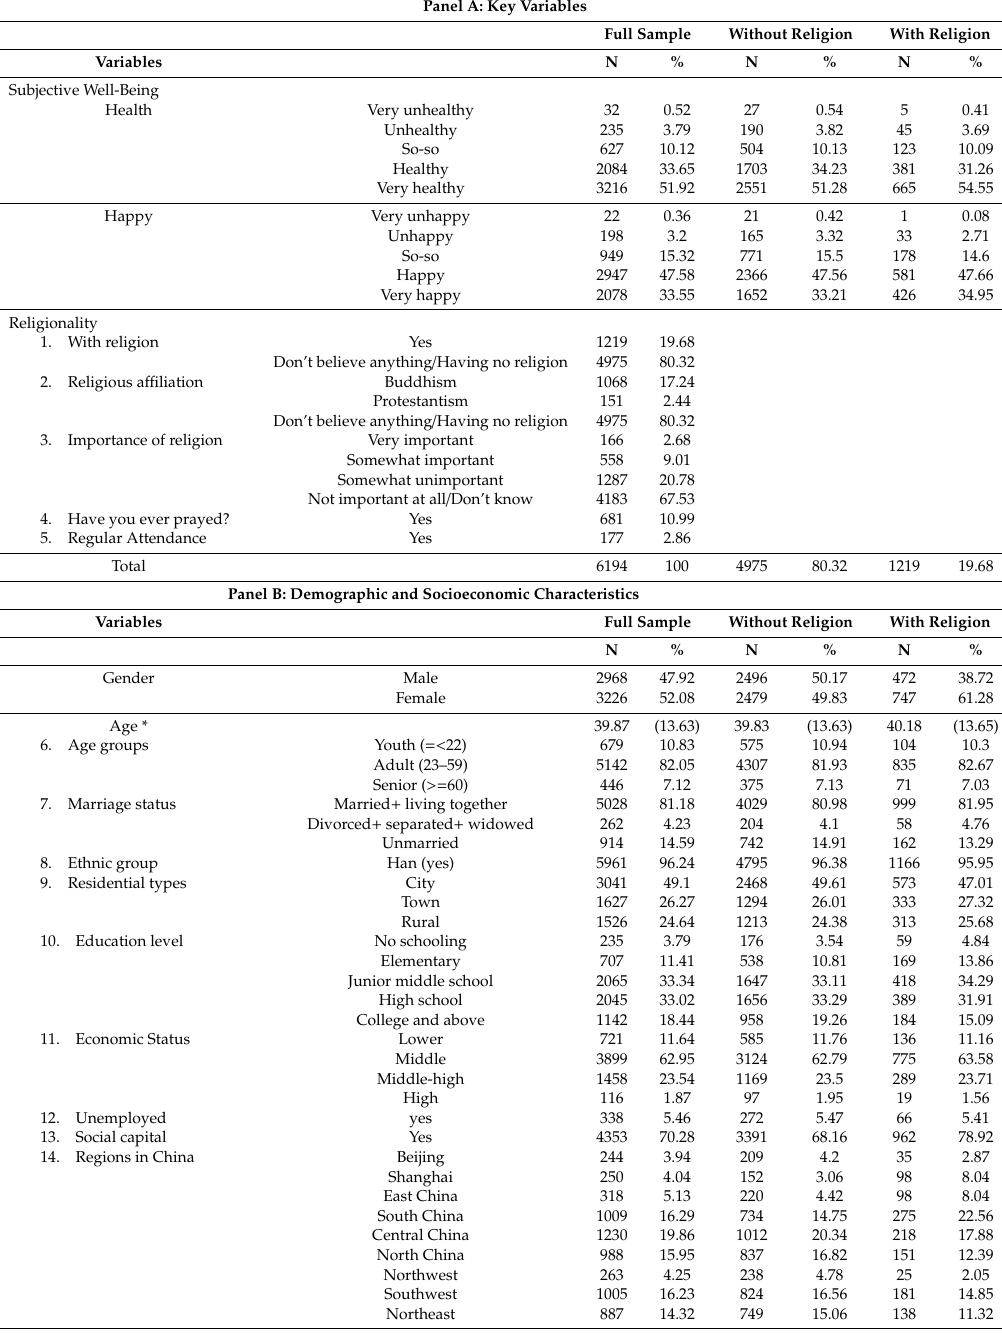
Table 1. Descriptive statistics of the